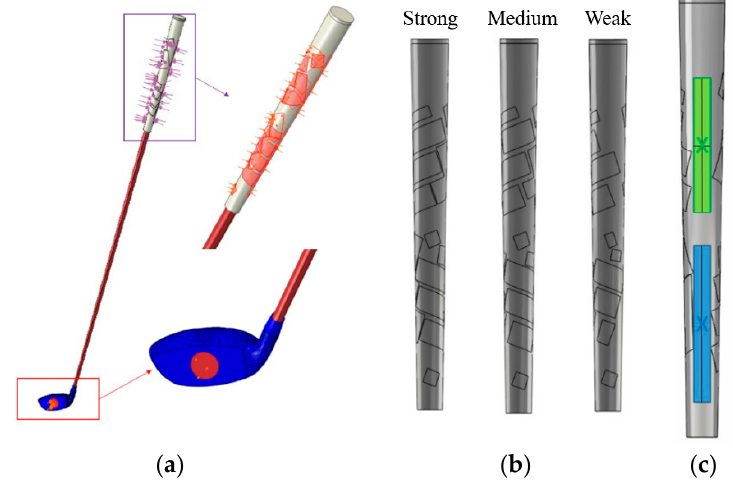
Figure 6. ( a ) Modeling of ball contact and grip zones; ( b ) Representation of grip zones on the numerical model by grip strength; and, ( c ) Reference points used to calculate vibratory doses.